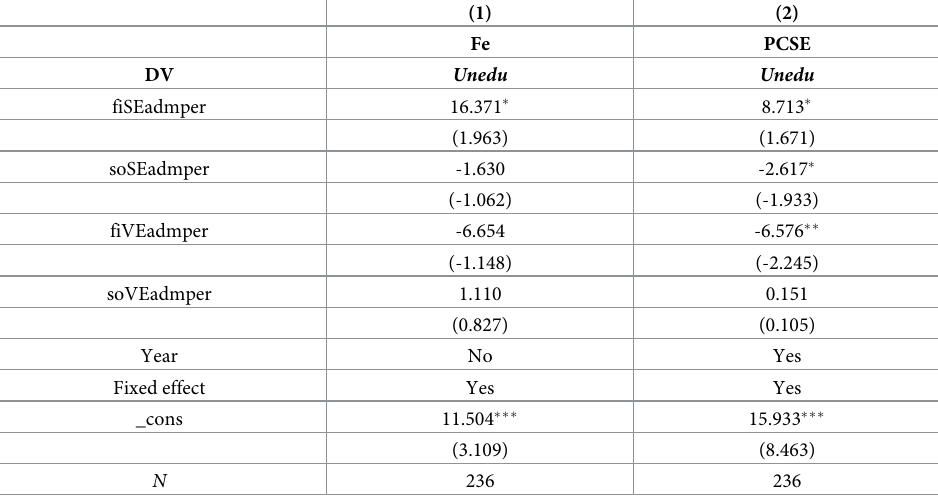
Table 12. The results of administrative expenditures on RSE correction with RVE.